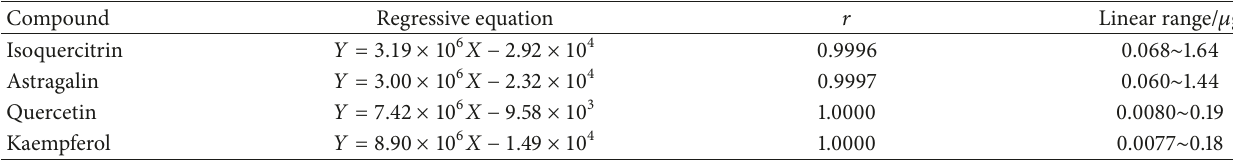
Table 2: Regression equations and linear ranges for four compounds.